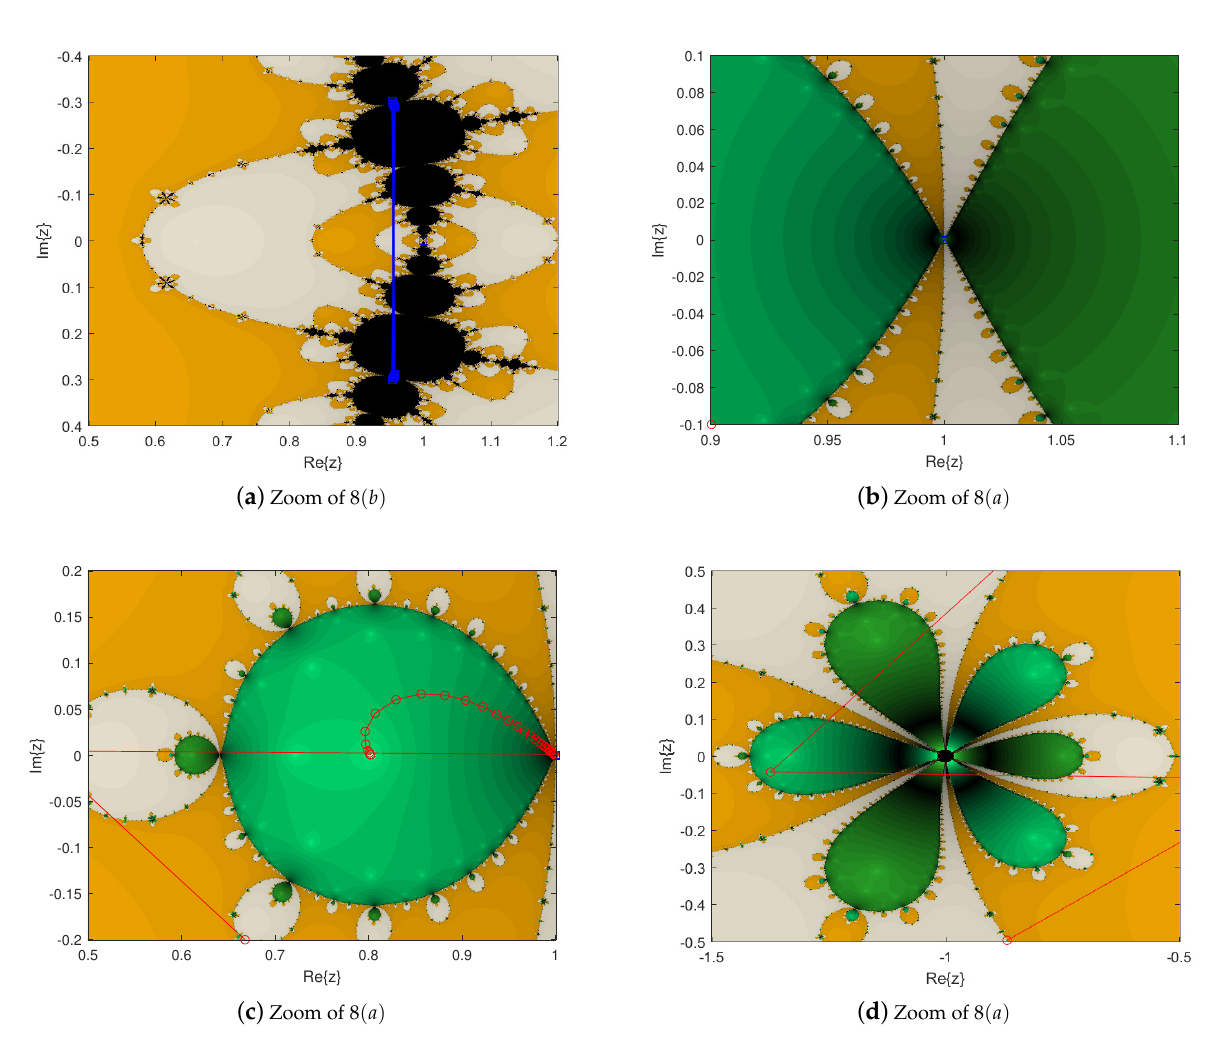
Figure 9. Local detail of Figure 8.